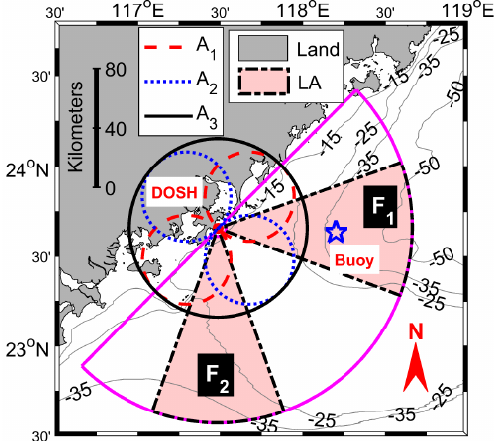
Figure 4. Geographic map of the field experiment at DongShan (DOSH), Fujian province, China. The ideal antenna pattern is superposed on the map. Thin gray lines are the contour lines of the water depth. The fanwise area enclosed by a thick pink line is the radar’s detection area. The two light-pink patched fanwise areas, named F 1 and F 2 and centered where the antenna patterns of the two loops intersect, is the selected 40-degree local area (LA) for calculating the time-averaged local spatial coverage rate (TLSCR). A buoy (blue pentagram) equipped with an acoustic Doppler current profiler (ADCP) is located in F 1